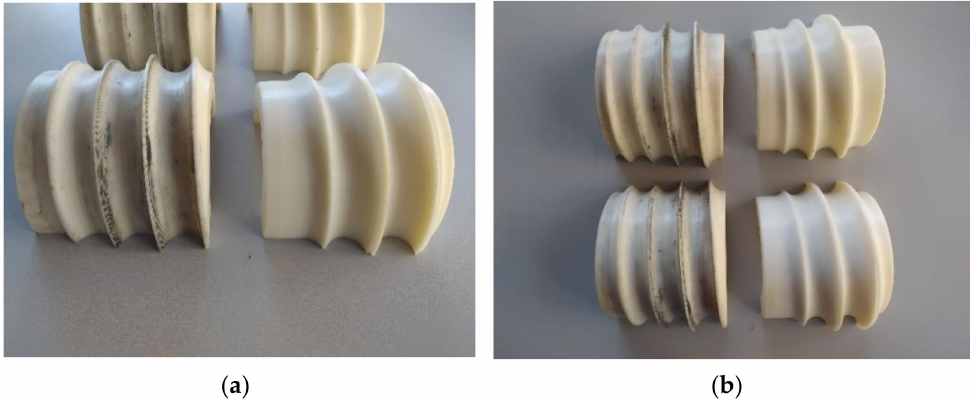
Figure 9. Tools used for model tests: ( a ) comparison of two different cutting methods; ( b ) top—a set of roller tools with one knife, bottom—a set of roller tools with two knives. ABS material is characterized by very high hardness and scratch resistance, but it is not resistant to contact with acids, alkalis and acetone.